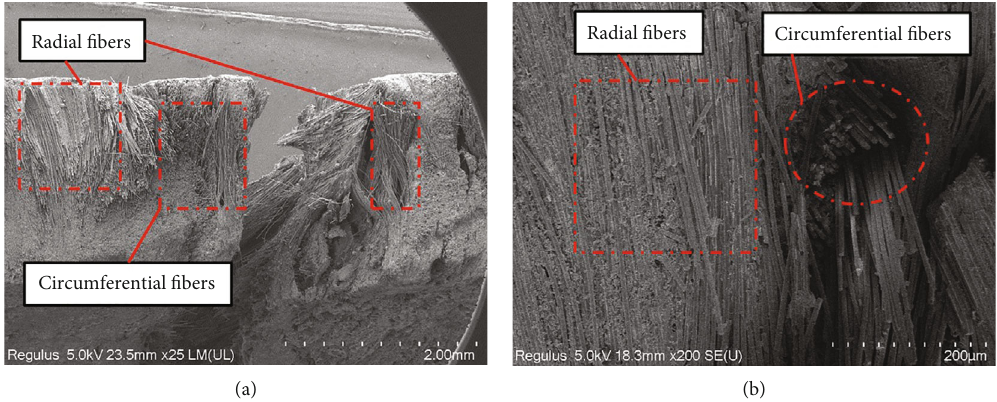
Figure 12: SEM of the cut section: (a) 2.00mm and (b) 200 μ m.